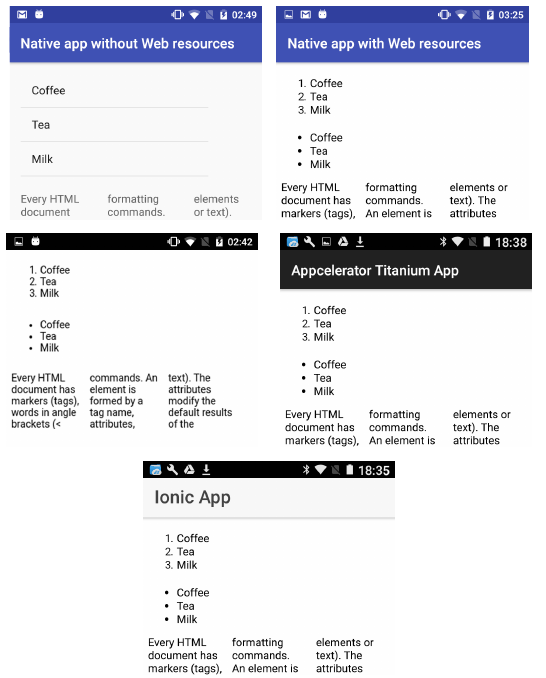
Fig. 1. Components ”text in sorted list”, ”text in unordered list” and ”text in columns” implemented in the native application (without Web resources), native application (with Web resources), Cordova application, Appcelerator application and Ionic application, respectively.